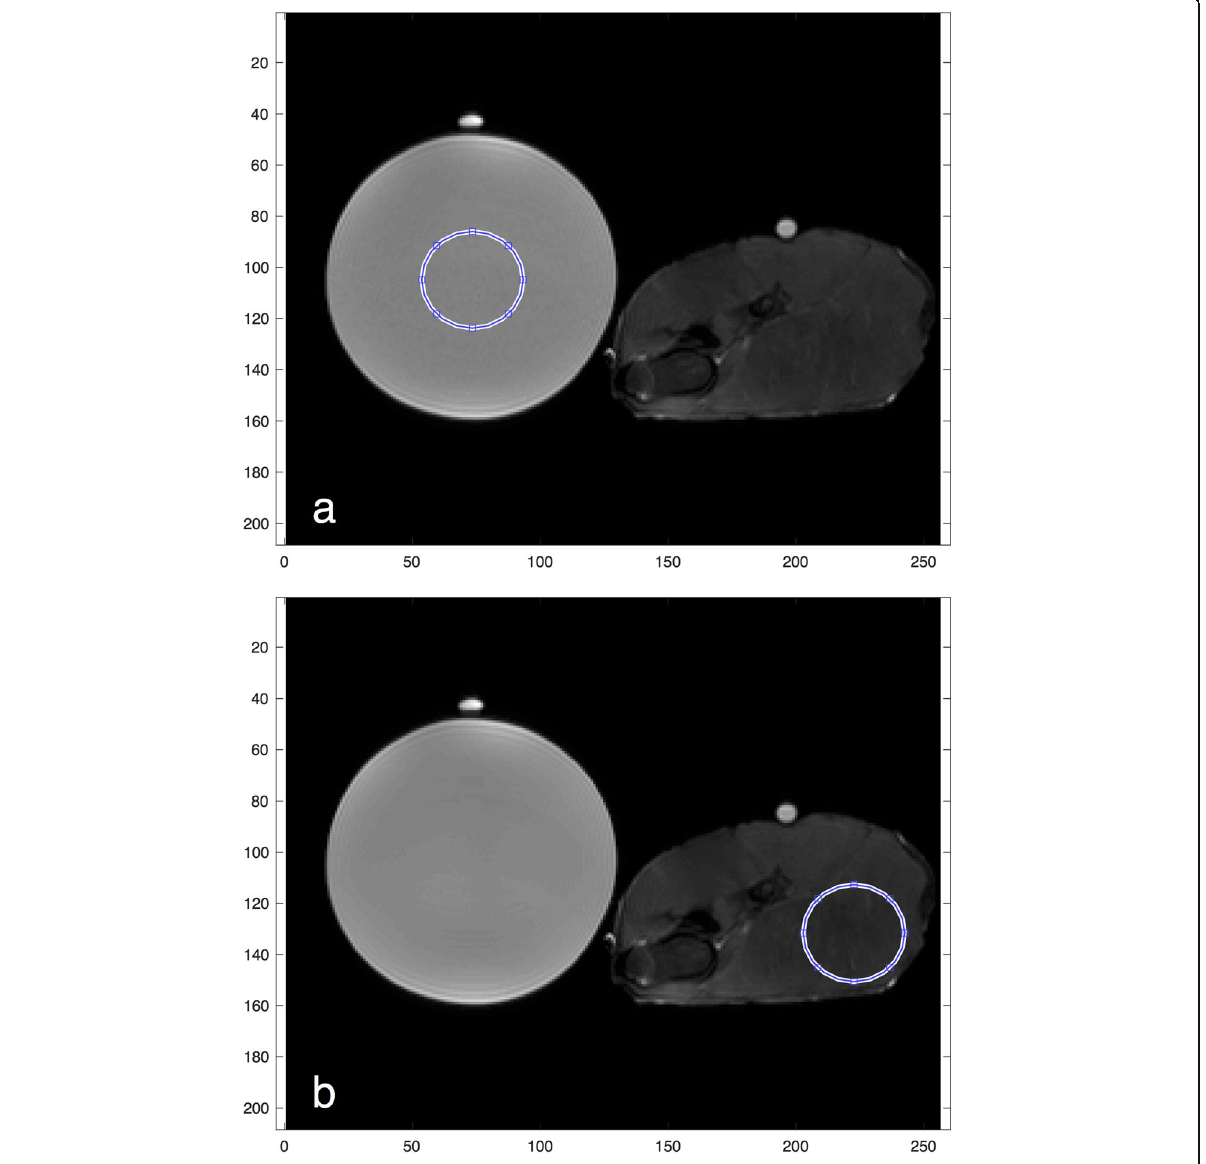
Fig. 1 a , b Example of regions of interest (ROIs) used to calculate texture features for the water phantom ( a ) and tissue phantom ( b ). Identical circular ROIs were placed in the centre of the water phantom and in a homogenous muscle group of the tissue phantom